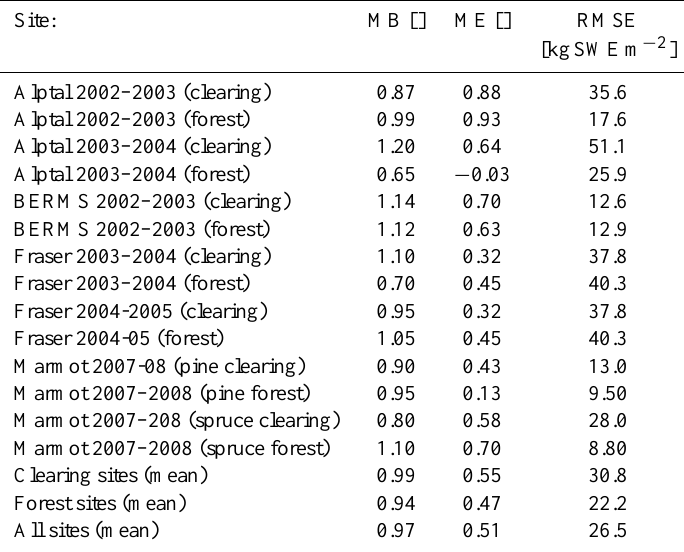
Table 3. Determined model bias index (MB), model efficiency index (ME), and root mean square error (RMSE) for simulations of snow water equivalent (SWE) at individual